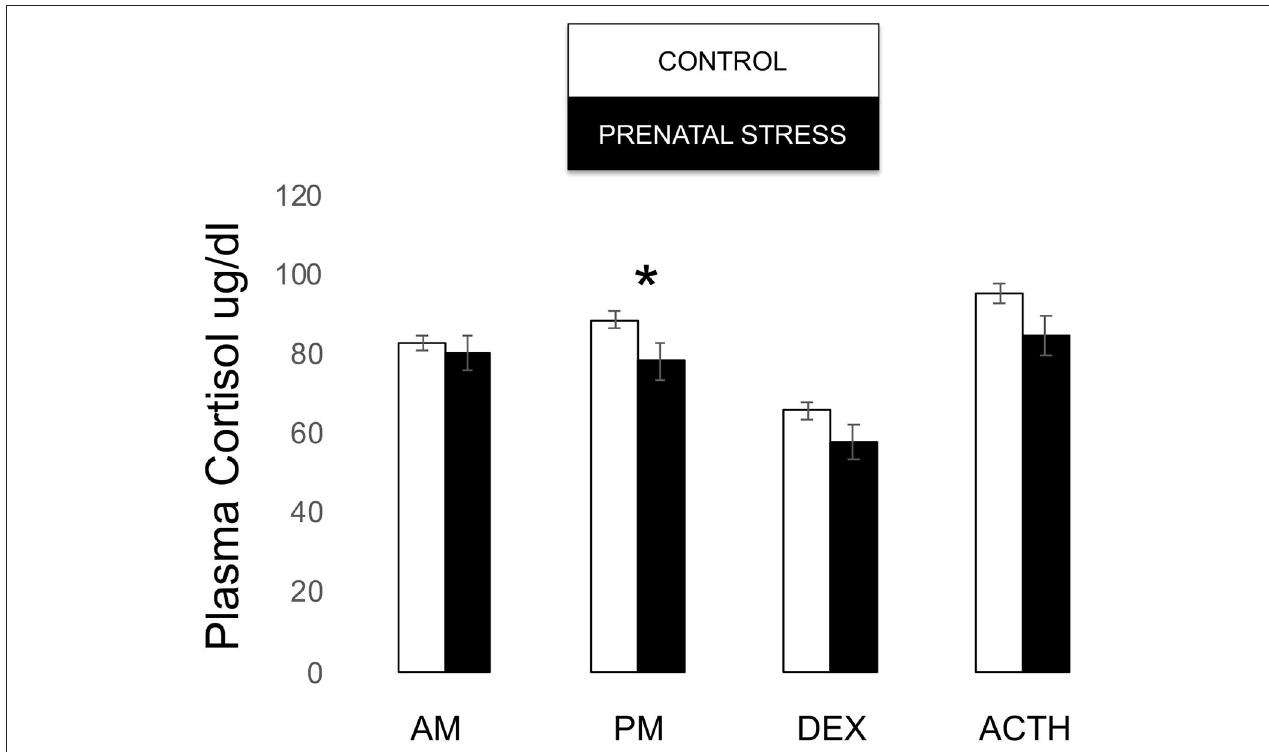
FIGURE 6 | Plasma cortisol measures during biobehavioral assessment between offspring of prenatally stressed mothers ( n = 39) and control mothers ( n = 149). Means are presented ± standard error of the mean. * p <